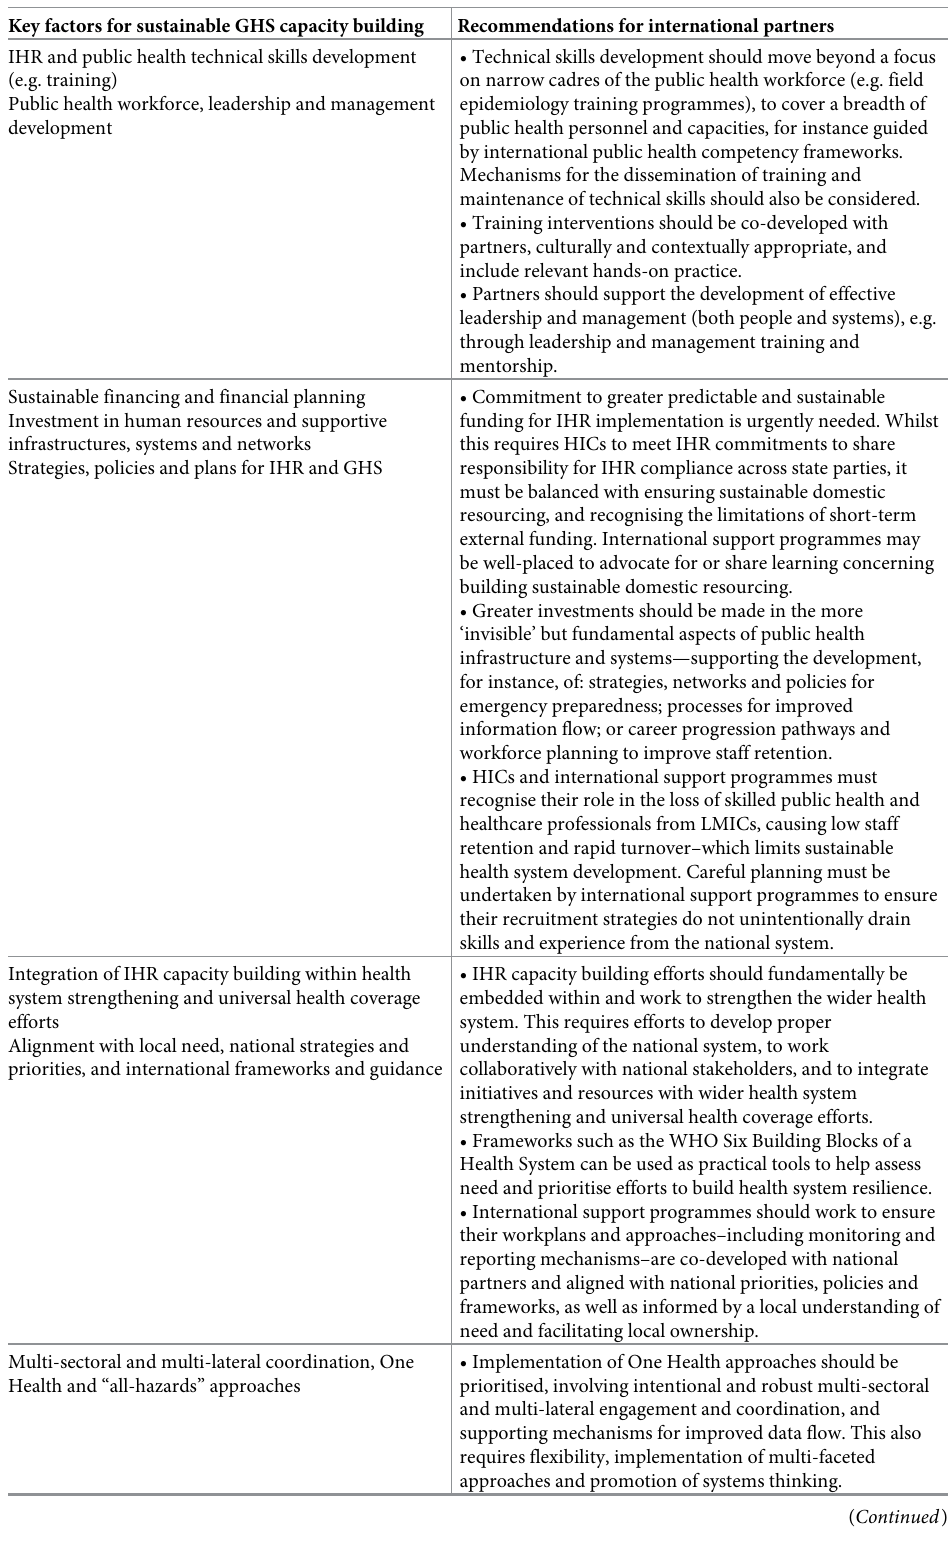
Table 1. IHR capacity building perspectives and approaches: Recommendations for international support